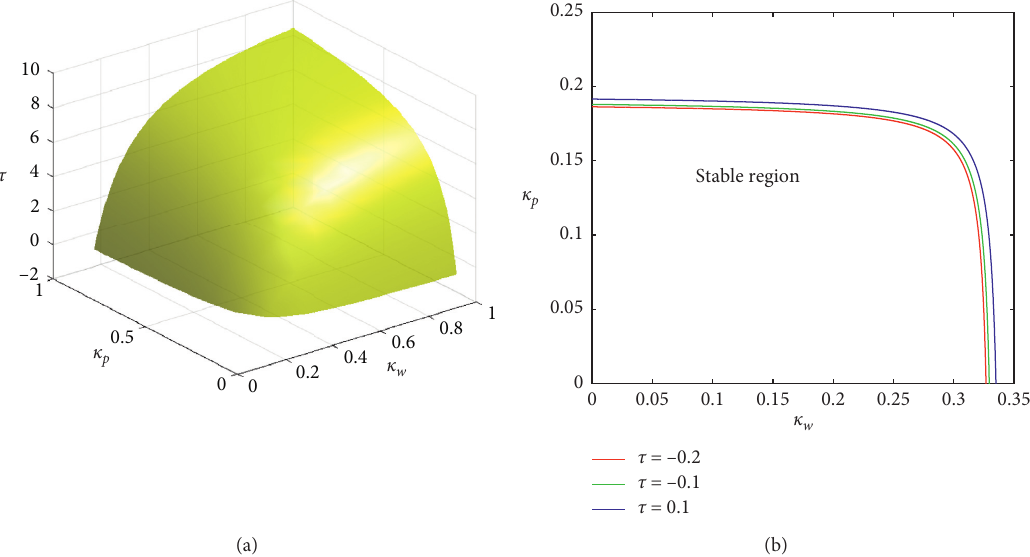
Figure 1: Stable region for adjustment speeds and τ . (a) 3D stable region for κ when δ � 0 .